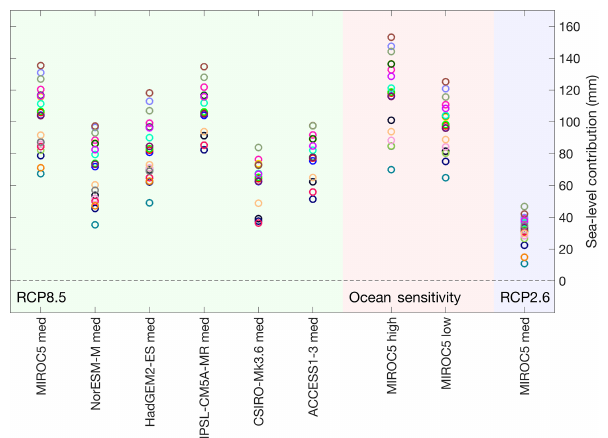
Figure 12. Overview of sea-level projections for different CMIP5 experiments. All contributions are calculated relative to experiment “ctrl_proj”. The colour scheme is the same as in previous